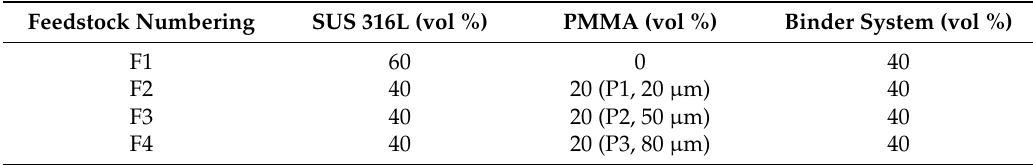
Table 4. Feedstocks with various polymethyl methacrylate (PMMA) space holder sizes (20, 50, 80 µ m) and their volume